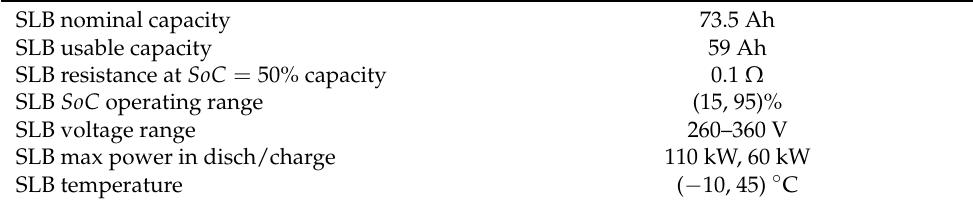
Figure 9. Second-life model comparison simulator framework with battery performance and thermal models at the pack scale and the aging models at the cell scale. Table 6. Battery parameters at SoH =